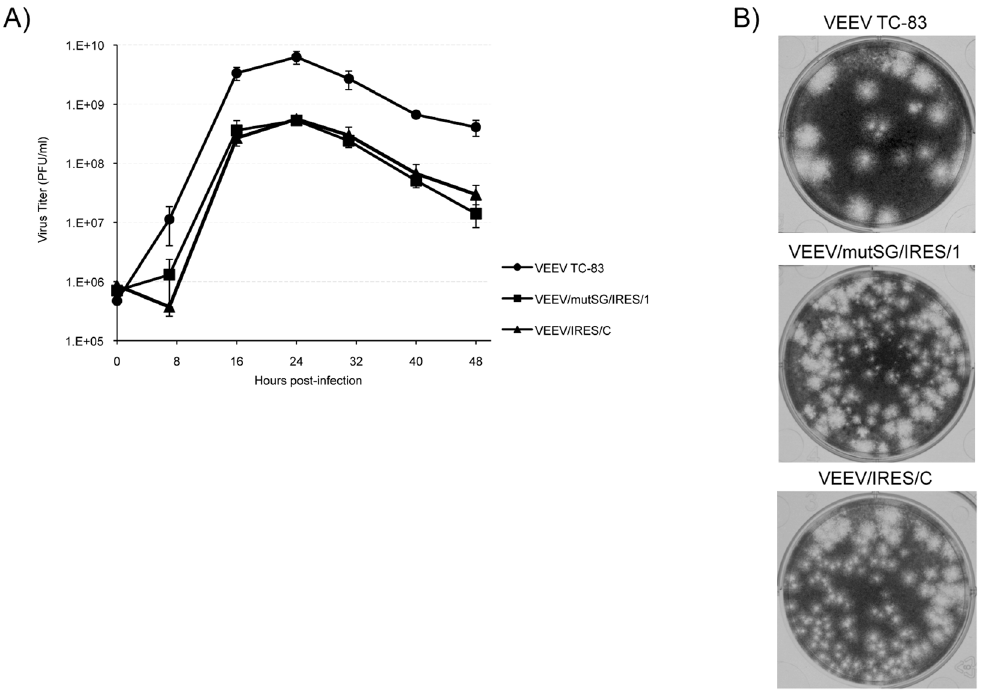
Figure 3. Replication of recombinant TC-83/IRES viruses and parental TC-83 on Vero cells. (A) Cells were infected with VEEV TC-83, VEEV/ mutSG/IRES/1 and VEEV/IRES/C at an MOI of 0.1 then viral titers in collected supernatants over time were determined by plaque assay. Bars indicate standard deviation for duplicate infections. (B) Vero cells were fixed with 10% formaldehyde 48 h post-infection and stained with crystal violet to observed plaque size and morphology.